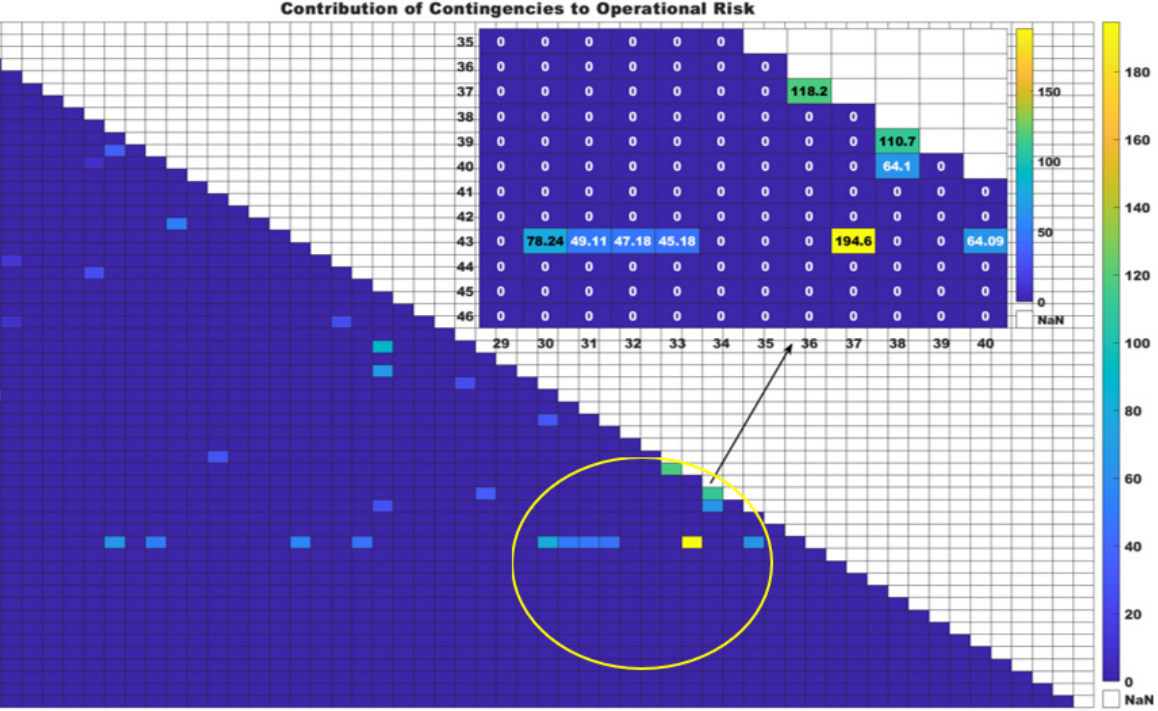
Figure 3. Contribution of contingencies towards OREL (OS-1). The color scale indicates the contribution of each contingency (defined by Equation (8)), as quantified by the color bar on the right, in the relevant unit. The color scale is selected such that the lowest value is dark blue and the highest value is yellow.